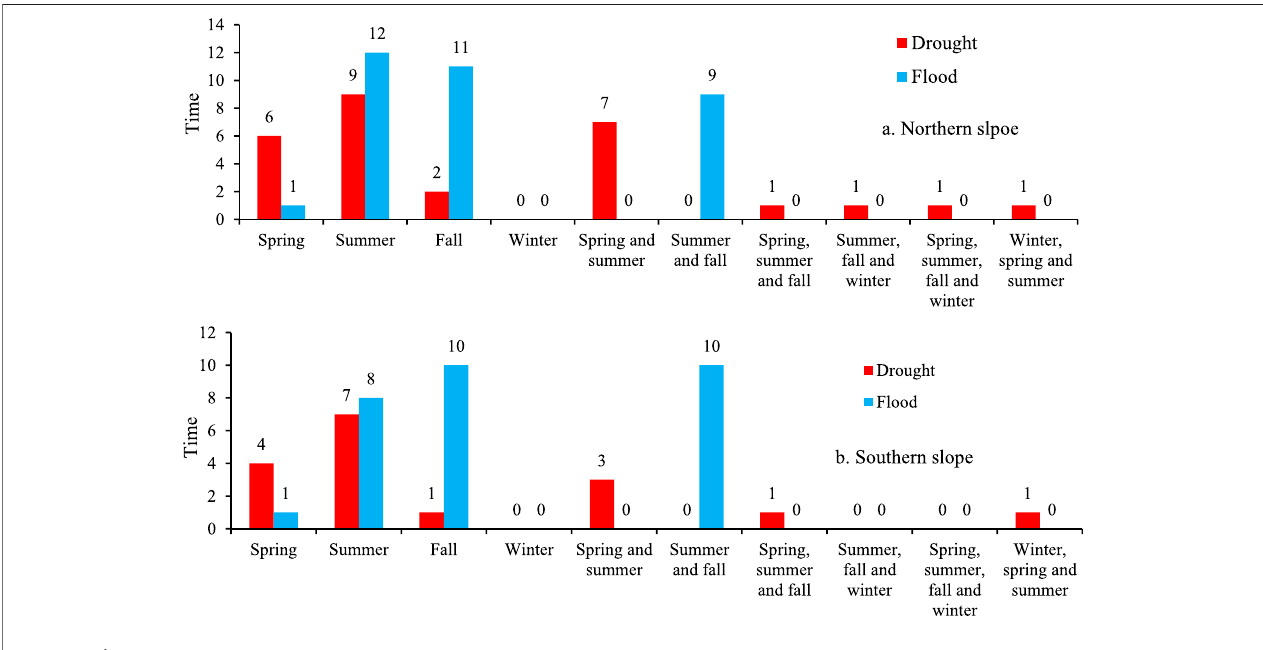
FIGURE 4 | The seasonal distribution of droughts and fl oods from 1850 to